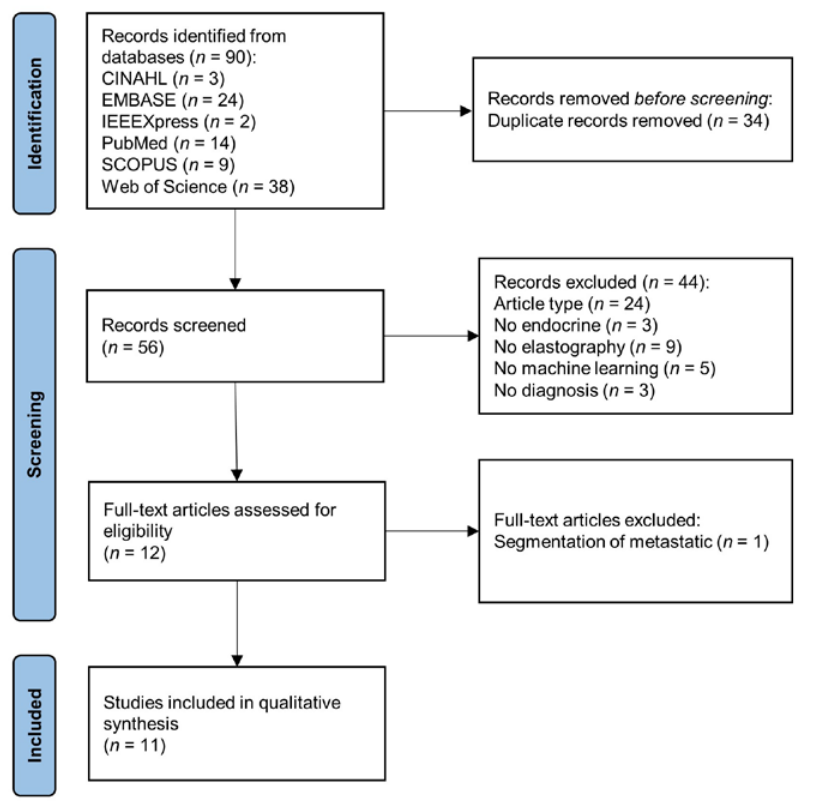
Figure 1. PRISMA flowchart of systematic search and screening. Table 1. Subject and dataset